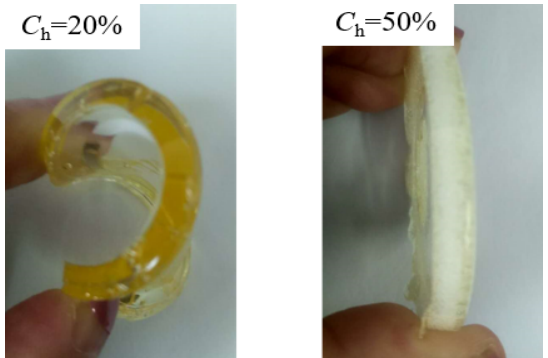
Figure 1. The bending of TPUs with different hard segment contents.